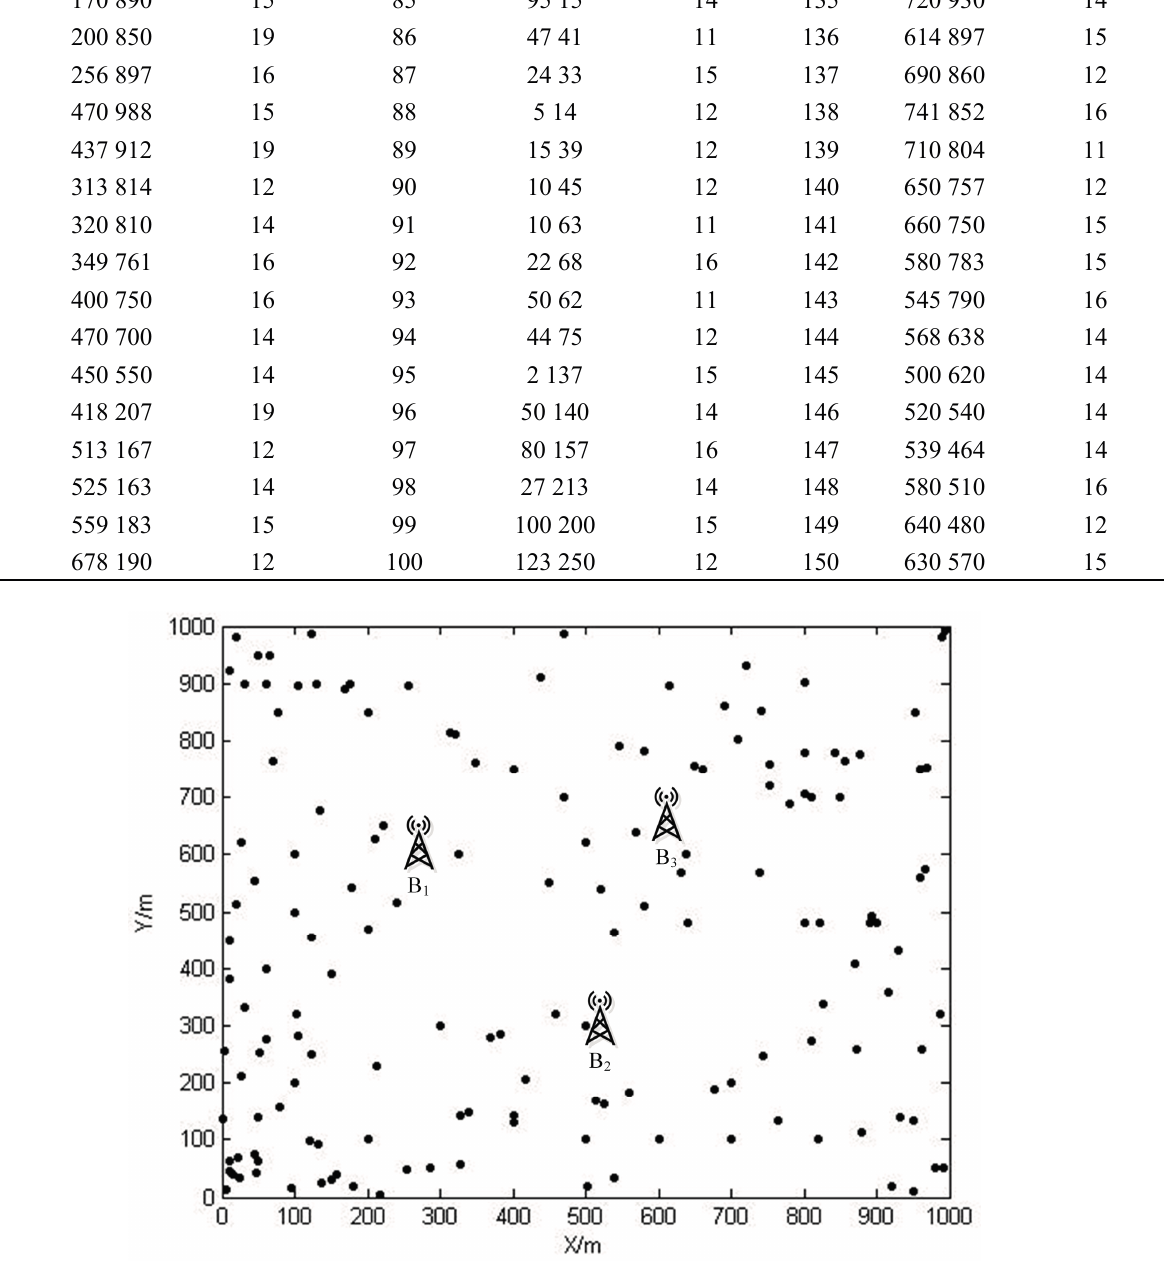
Figure 6. The sensor nodes in area D